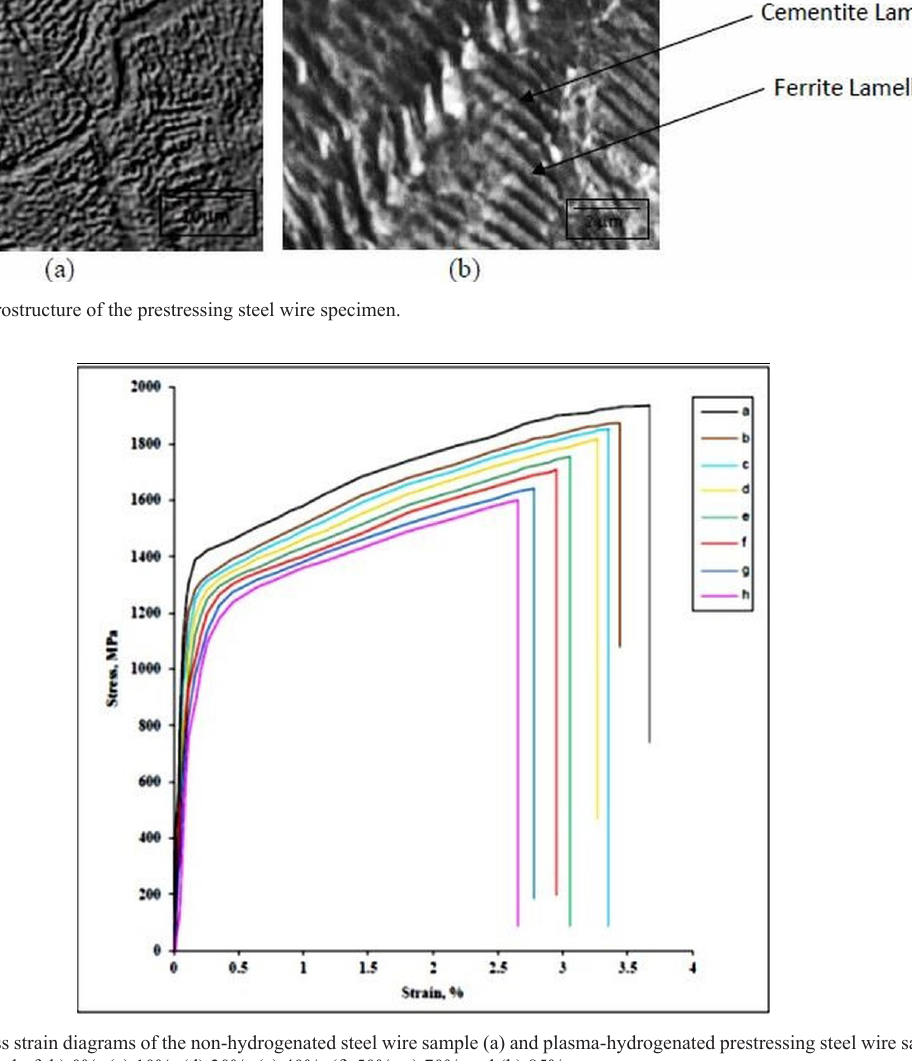
Figure 4. Stress strain diagrams of the non-hydrogenated steel wire sample (a) and plasma-hydrogenated prestressing steel wire samples at a various level of: b) 0%, (c) 10%, (d) 30%, (e) 40%, (f) 50%, g) 70% and (h)